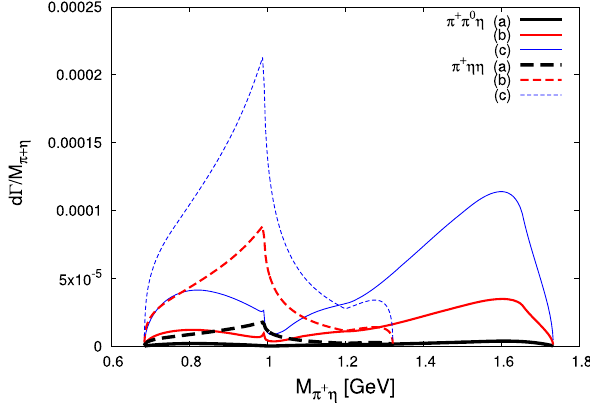
Fig. 10 Same as in Fig. 9. The labels (a), (b), (c) stand for the sets of parameters of Eq.